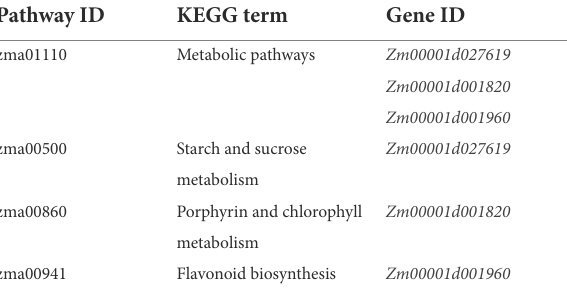
TABLE 6 Distribution of genes and pathways related to the RNA-seq